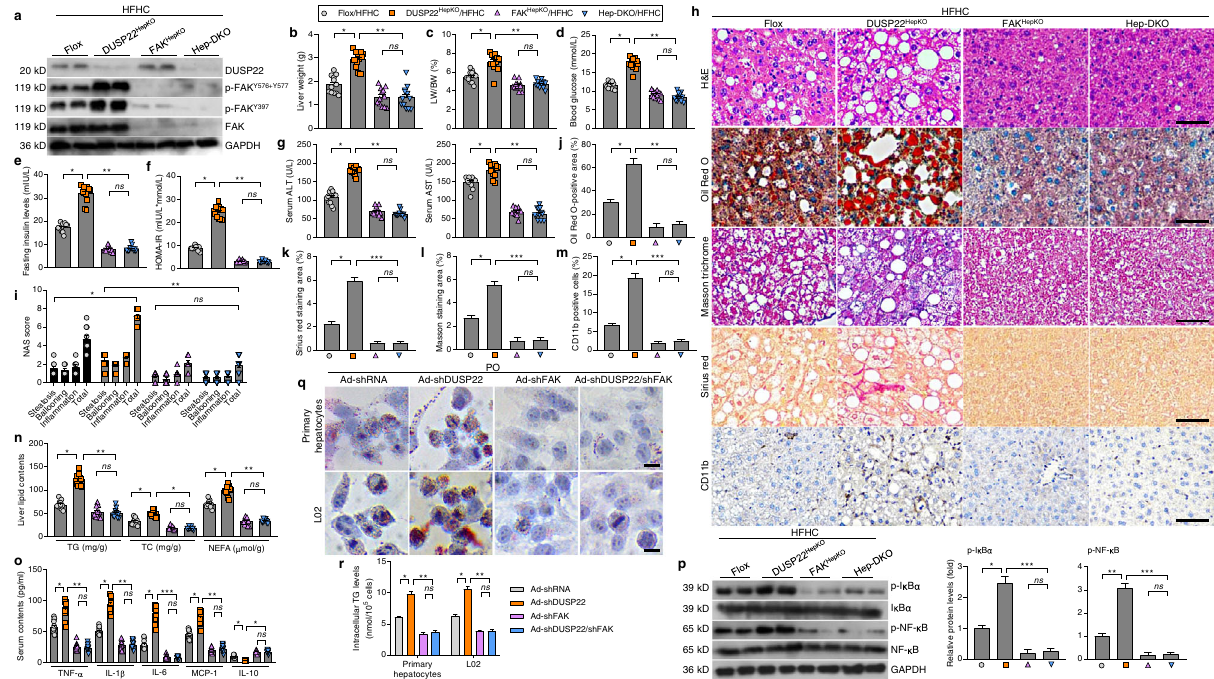
Fig. 6 | FAK inactivation id essential for DUSP22 function. a Representative westernblotting for the expression of DUSP22, p-FAK Y576+Y577 , p-FAK Y397 , and FAK in theliversfromtheDUSP22 HepKO mice,hepatocyte-speci fi cFAK-knockout(FAK HepKO ) mice, hepatocyte-speci fi c DUSP22 and FAK double knockout (Hep-DKO) mice and Floxmiceaftera24-weekHFHCfeeding( n =4micepergroup). b – g Measurements of b liver weight, c ratio of LW/BW, d blood glucose levels, e fasting insulin levels, f HOMA-IR,and g